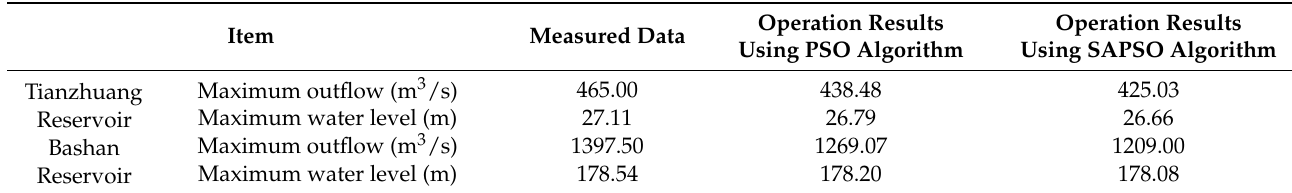
Table 5. Comparison of operating results for the 13 August 1974